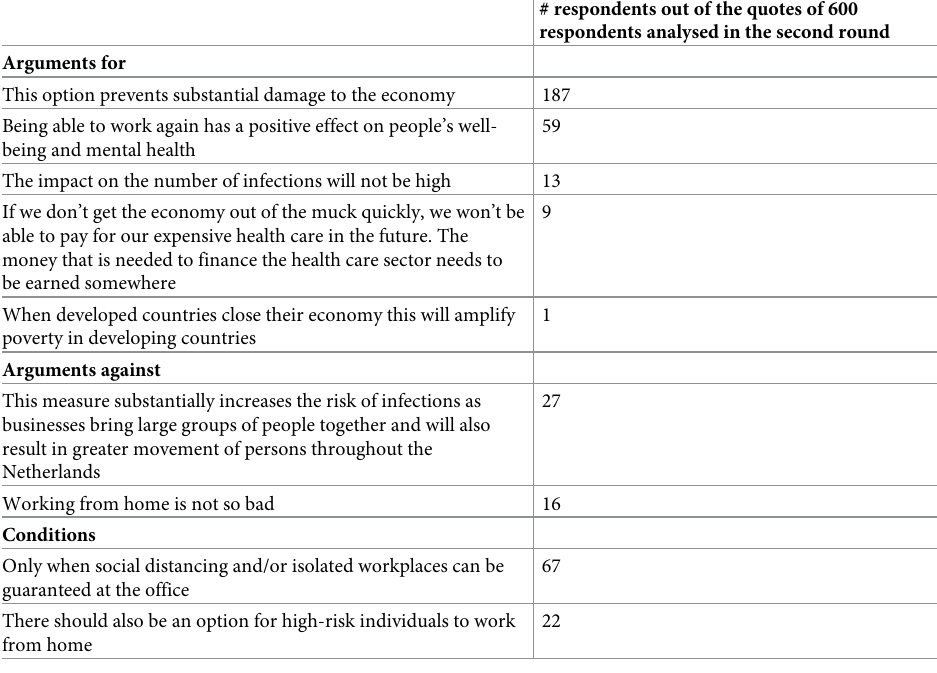
# respondents out of the quotes of 600 respondents analysed in the second round